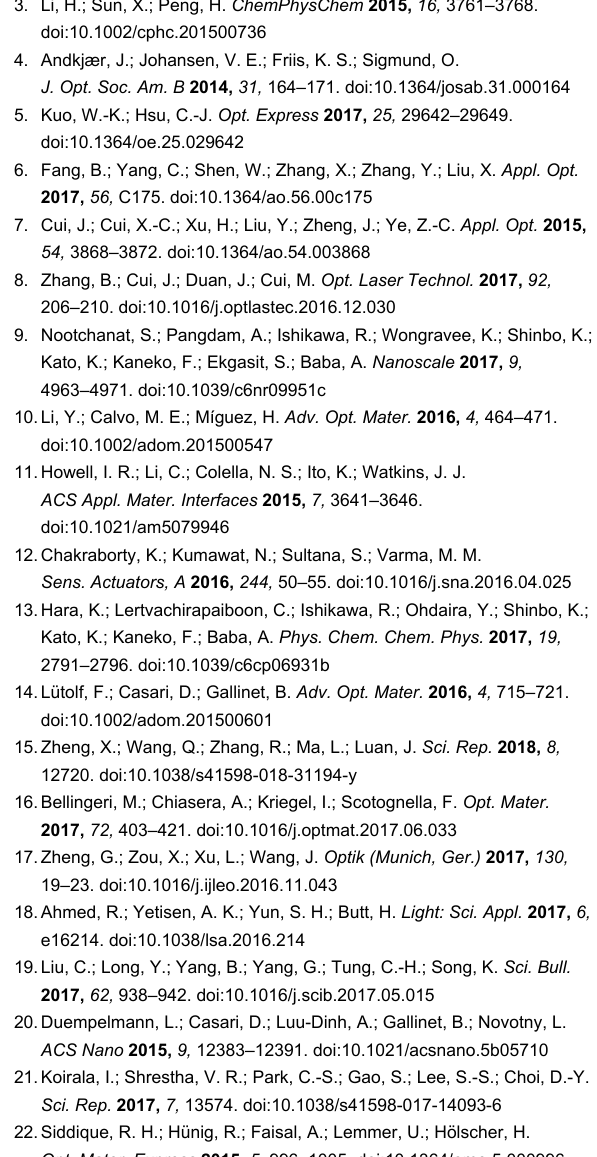
methylsiloxane (PDMS) and cross-linker were obtained from Sylgard 184 (Dow Corning,